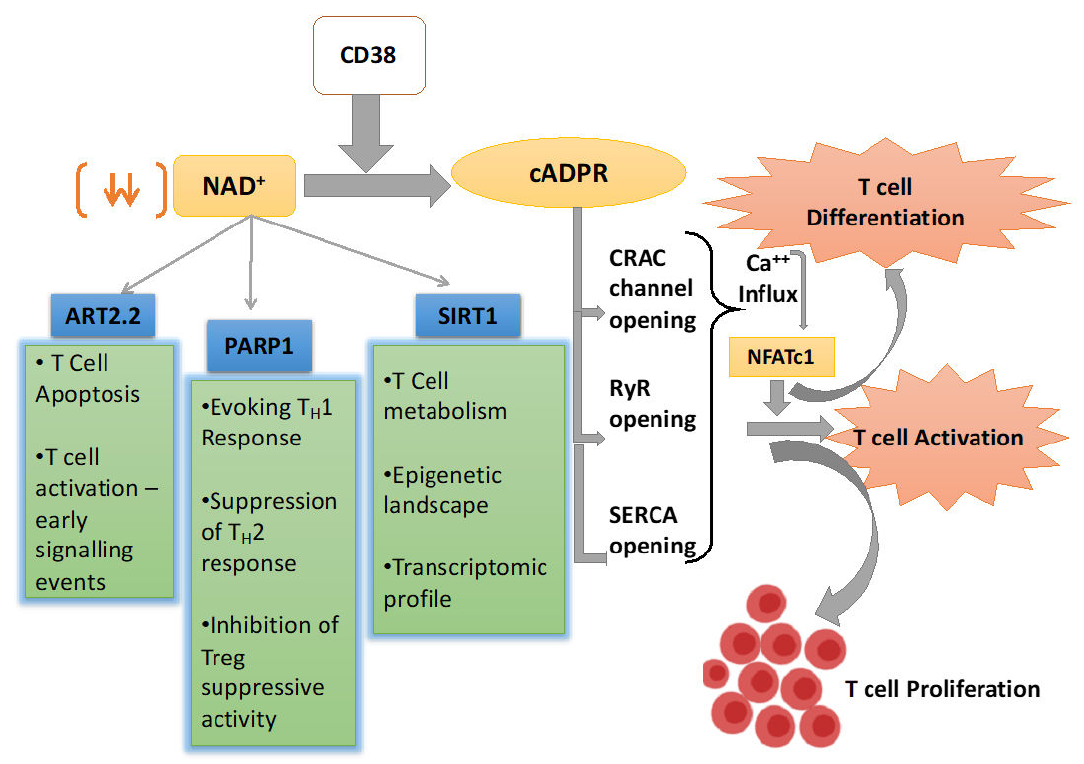
Figure 1. Schematic representation of nicotinamide adenine dinucleotide (NAD + ) utilizing pathways inside the T cell and their overall e ff ect on T cell response. CD38 is the major mammalian NAD + glycohydrolase (NADase) which metabolizes NAD + and generates cyclic ADP-ribose (cADPR), which promotes T cell activation and proliferations through facilitating Ca 2 + signaling. CD38 expression also depletes NAD + level and hence a ff ect the enzymatic activity of di ff erent NAD + consuming enzymes like Sirt1, PARP1, and ART2.2, which play pivotal role in T cell fate